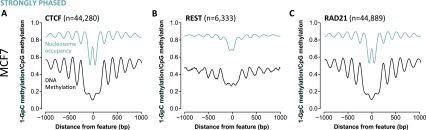
CTCF, RAD21, and REST are associated with patterns of nucleosome organization. (A–C) Nucleosome occupancy (teal lines) and endogenous methylation (CpG; black lines) were mapped ±1000 bp from the center (“0”) of each transcription factor binding site (CTCF, REST, and RAD21) and were determined to be “strongly phased” in MCF7 cells.